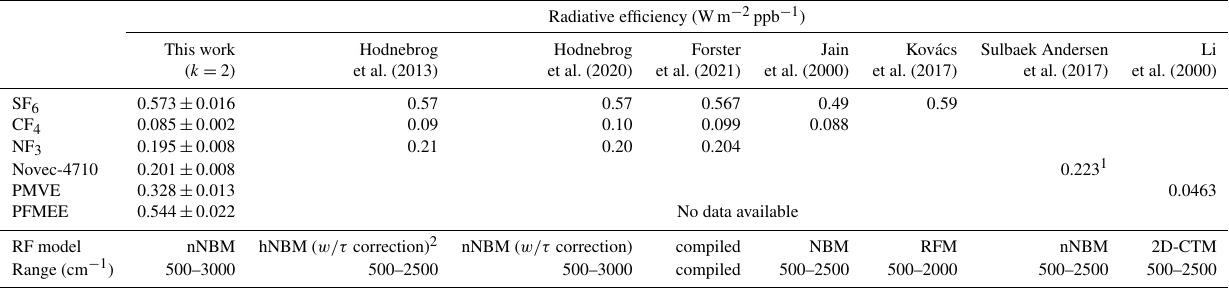
Table 2. Summary of the radiative efficiency values obtained in this study and previous studies. The confidence level of uncertainty of the radiative efficiency value in this study is